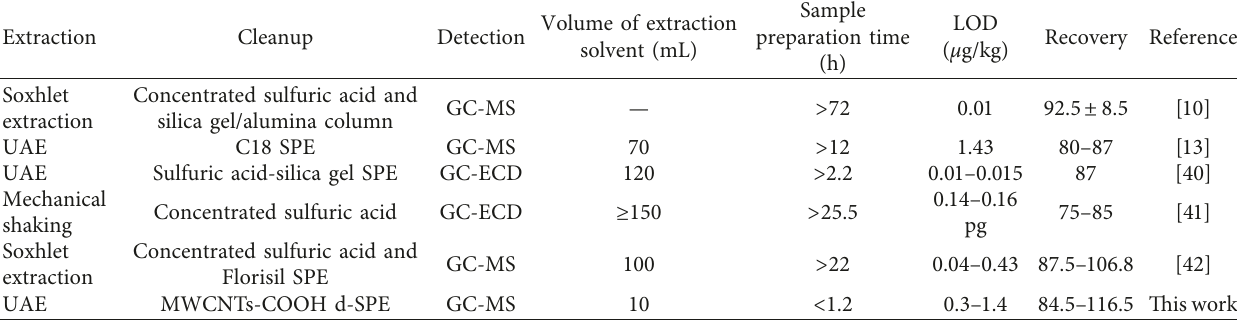
Table 2: Comparison of the proposed method with other methods reported in the literature for the determination of PCBs in vegetable